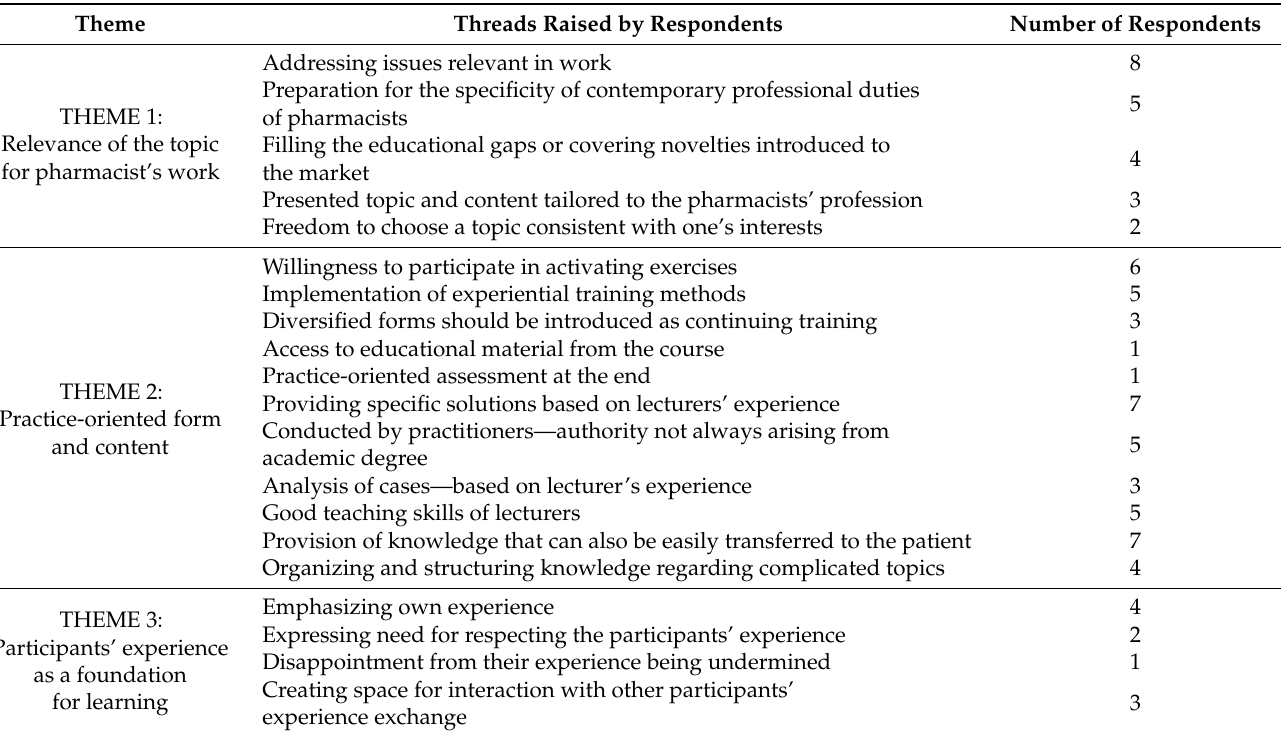
Table 3. Themes identified during the study with relevant threads raised by the